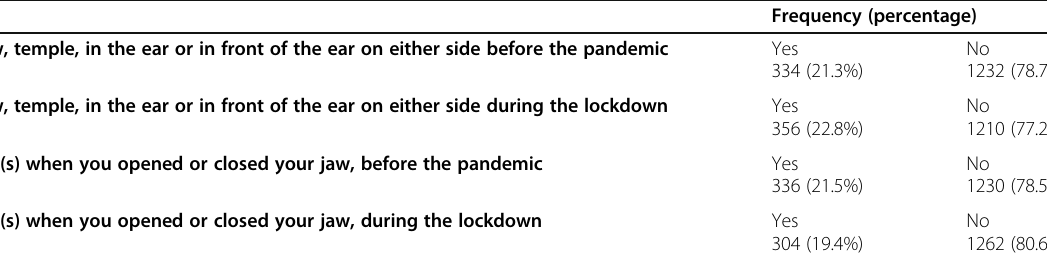
Table 5 Frequencies and percentages of replies to questions about temporomandibular disorders Pain in your jaw, temple, in the ear or in front of the ear on either side before the pandemic Yes